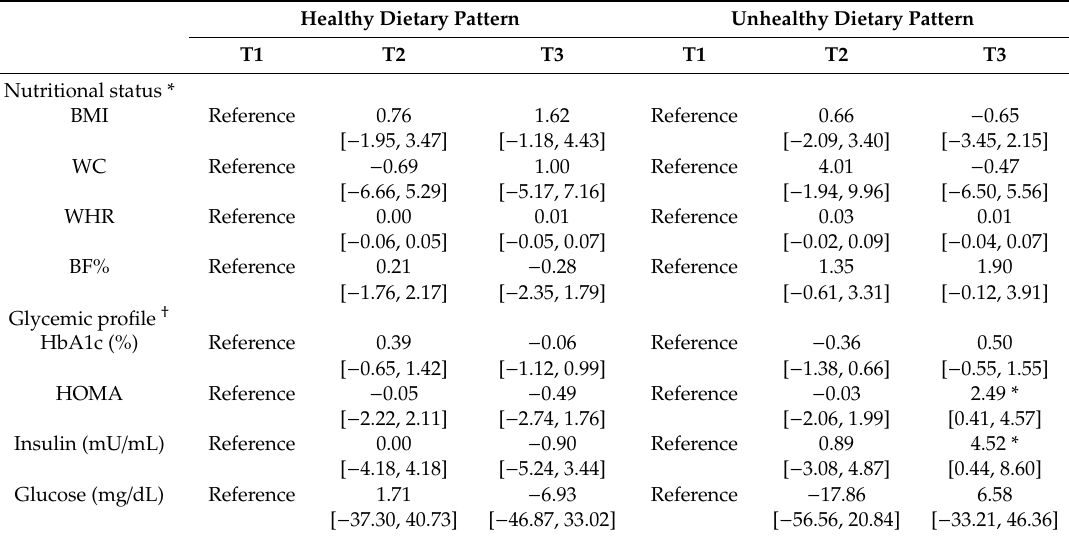
Table 4. Association of healthy and unhealthy dietary patterns with the nutritional status and the glycemic